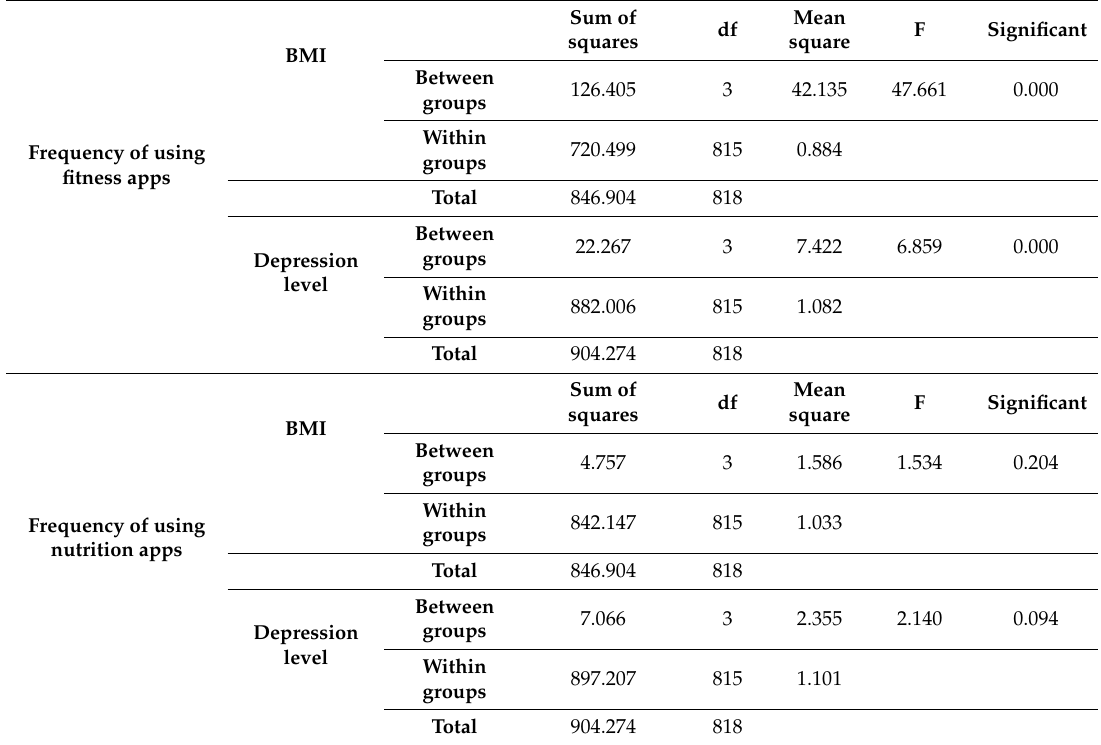
Table 4. ANOVA output.